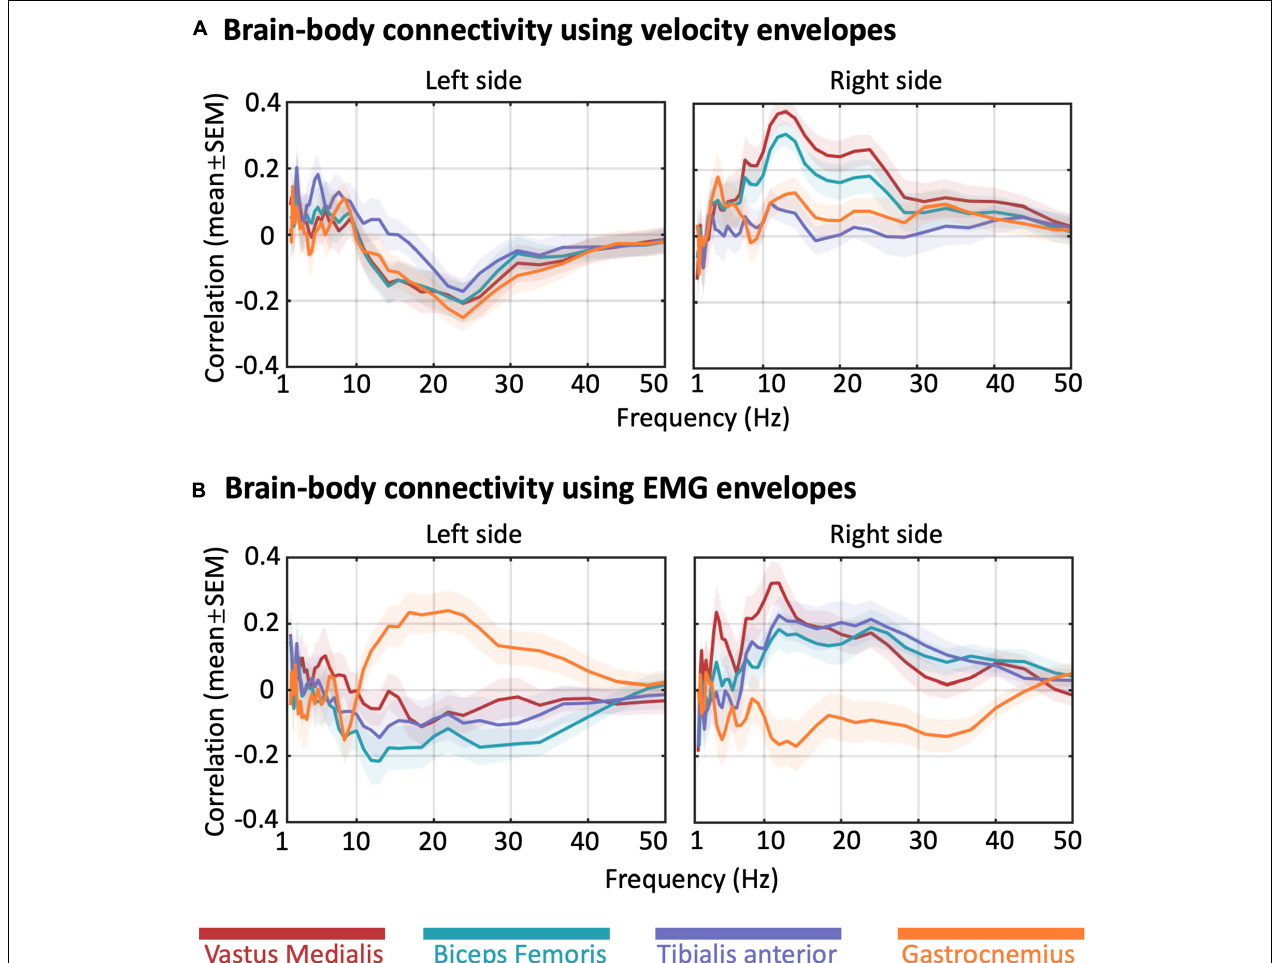
FIGURE 7 | Frequency-dependent brain-body connectivity for a representative region of interest. The plots show the brain-body connectivity calculated from the neural signal of the right primary motor cortex (M1), using (A) velocity envelopes and (B) EMG envelopes, respectively. Colored lines denote the mean across participants, and colored areas denote the standard error of the